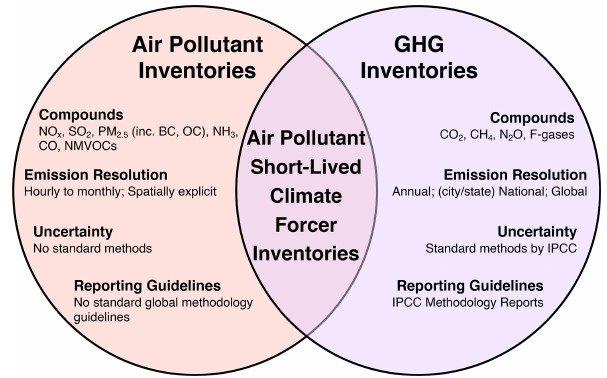
Figure 1. Schematic diagram illustrating the main characteristics of greenhouse gas (GHGs) vs. air pollutant inventories, also highlight- ing overlap of characteristics in inventories of air pollutant short- lived climate forcers (SLCFs). As discussed in the main text, an “air pollutant SLCF inventory” is largely a matter of context rather than a distinct category of inventory data. Also note that all the air pollutants and some of the GHGs listed above are considered SLCF